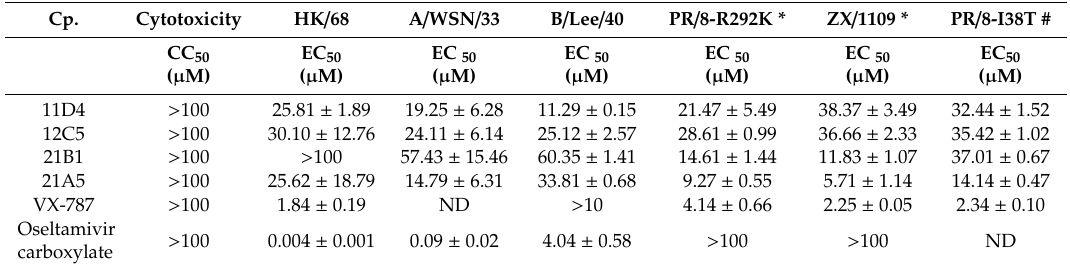
Table 2. The activities of the compounds against multiple influenza virus strains. Cp.